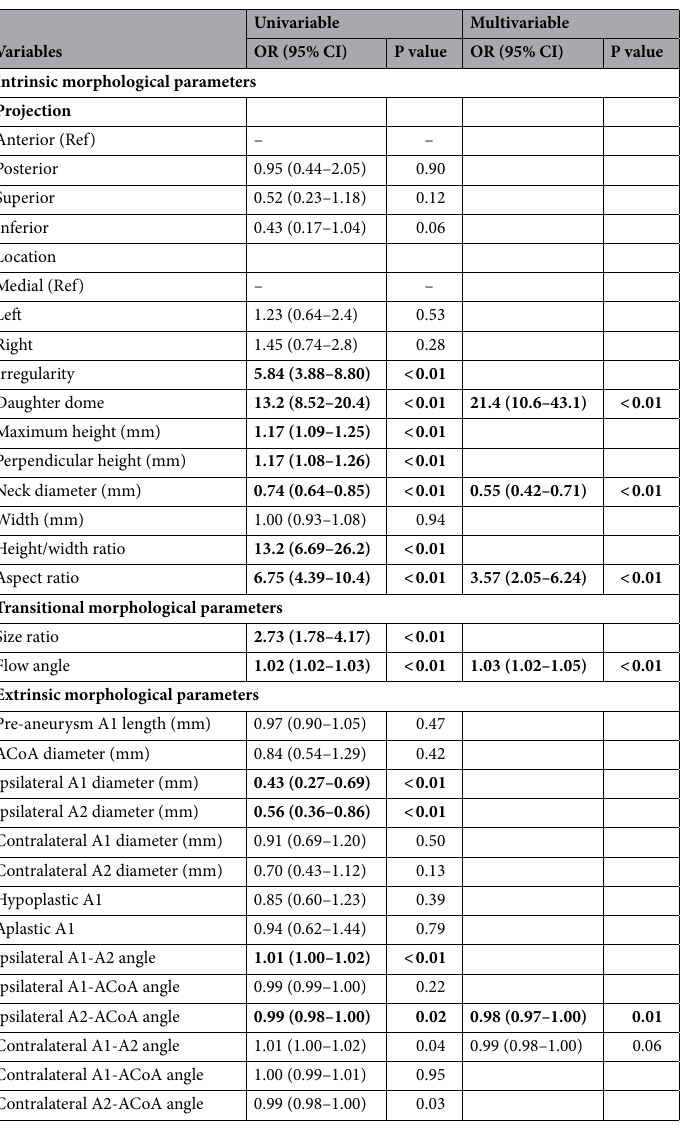
Table 2. Univariate and multivariate regression models for rupture of anterior communicating (ACoA) aneurysms. Ref